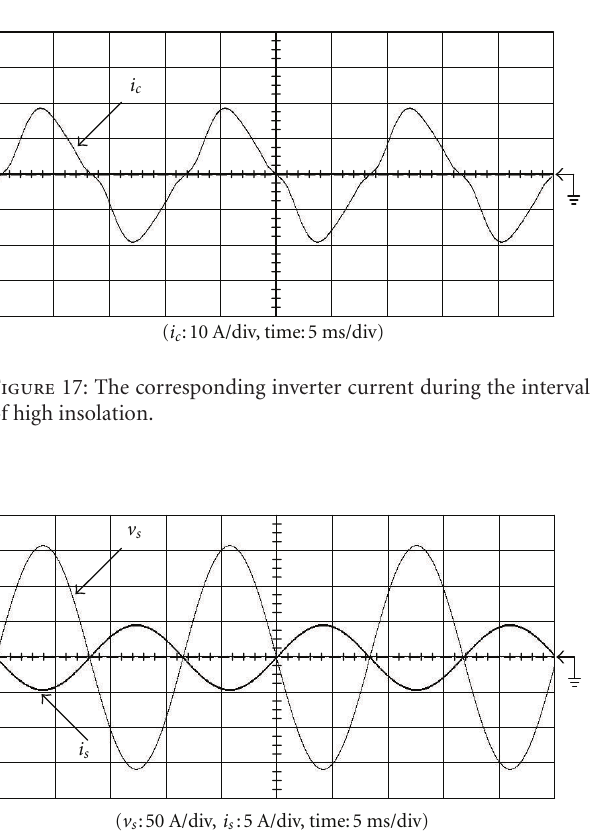
Figure 18: Filtered line current and line voltage during the interval of medium